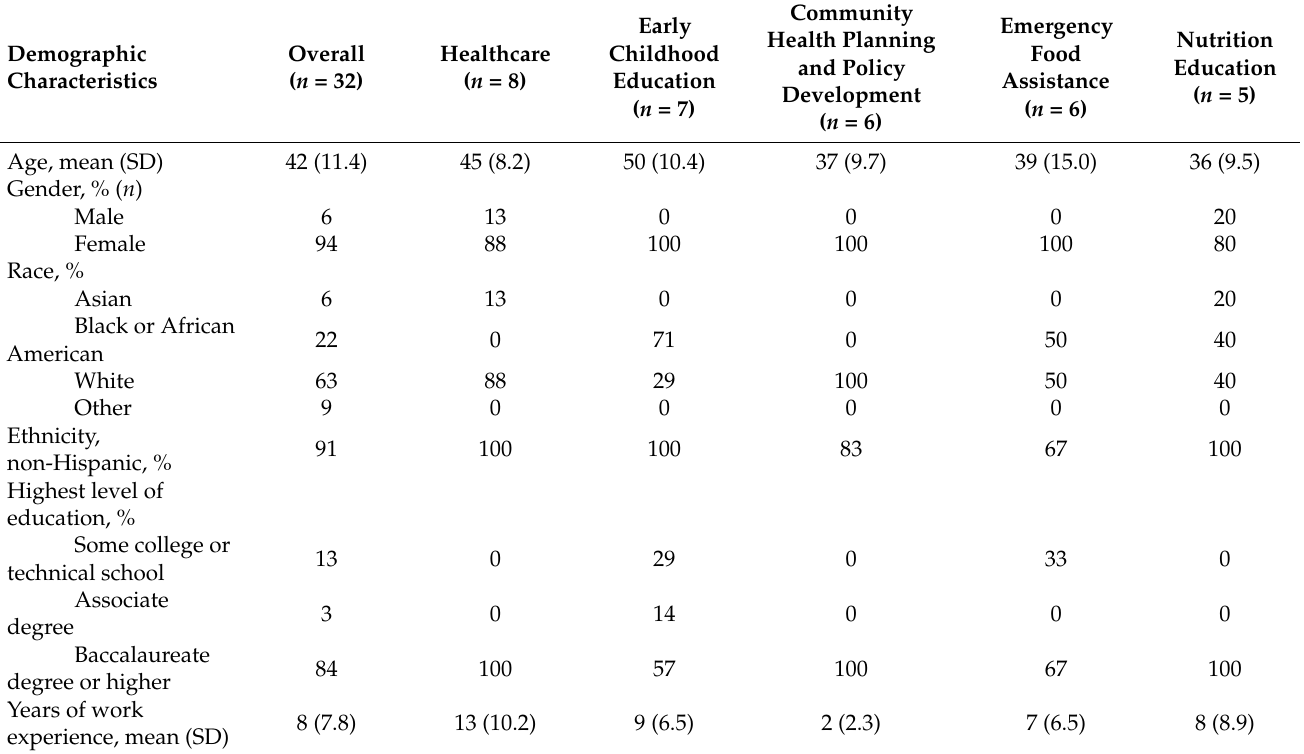
Table 1. Demographic characteristics by community stakeholder